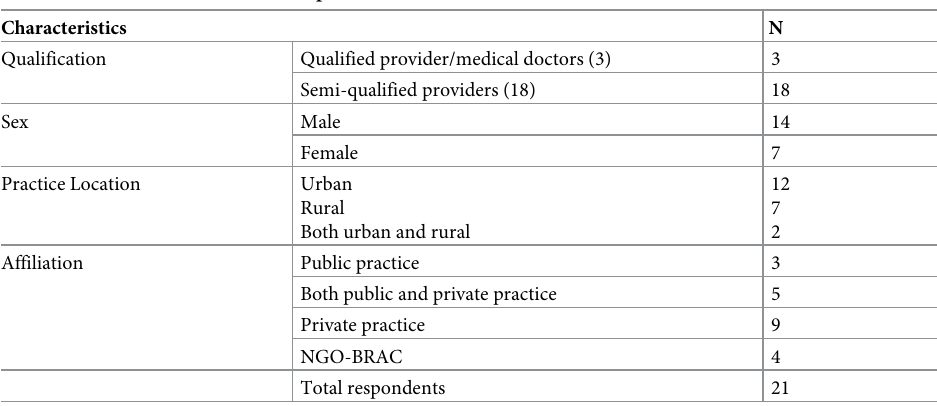
Table 2. Characteristics of healthcare providers.